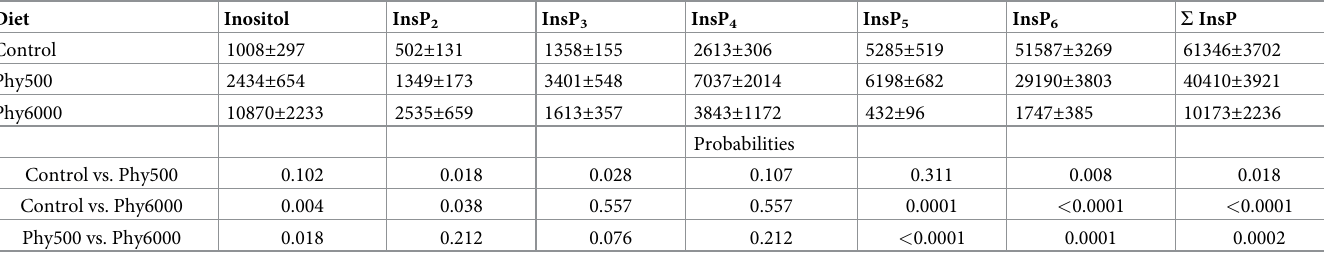
Table 4. Inositol and inositol phosphate (InsP 2-6 ) levels (nmol/g dwt) in ileal digesta of day 21 broilers 1,2